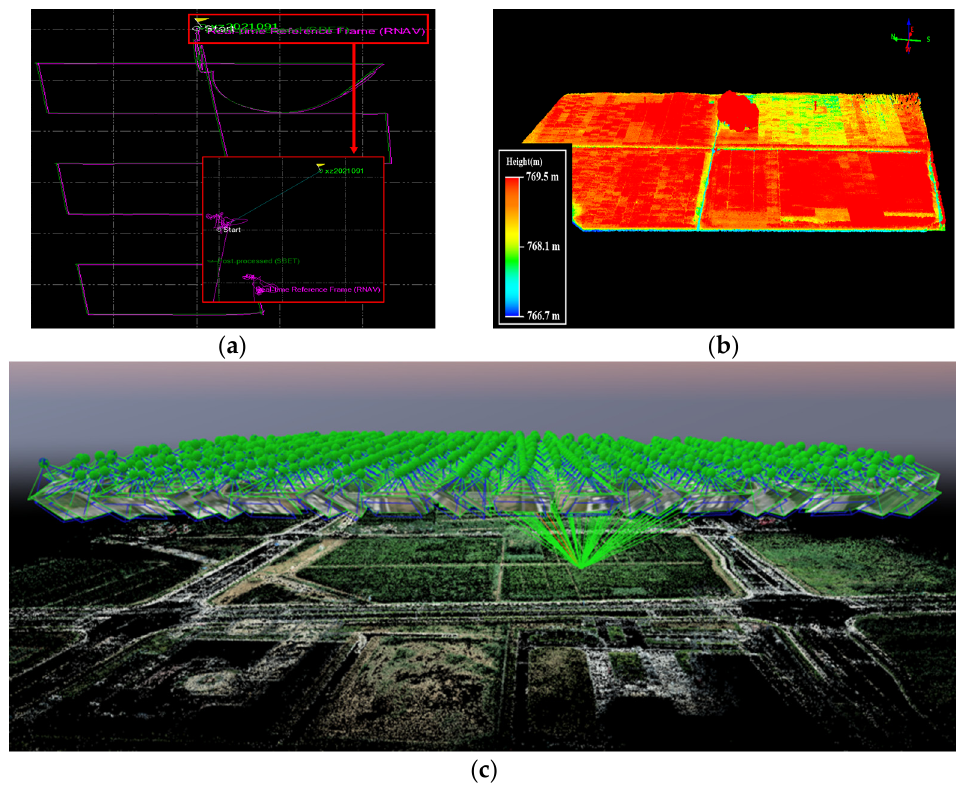
Figure 4. The processing interface: ( a ) Software interface for point cloud trajectory solution; ( b ) The processed point cloud data; ( c ) The flight path and camera location of where images were collected. A color space conversion, as shown in Equation (1), was applied to the orthophotos to suppress the information in the blue and red bands in the RGB orthophotos. This made the green component k , where k <